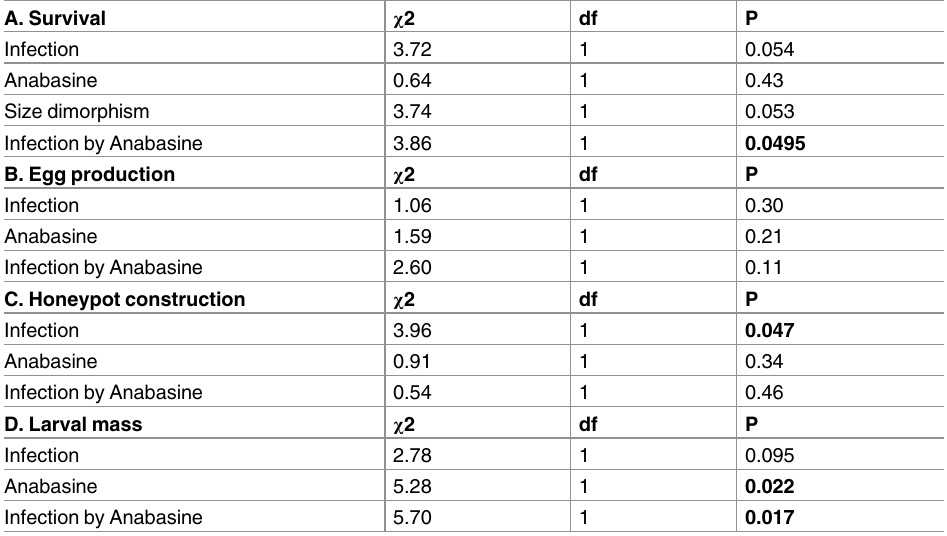
Table 3. Effects of Crithidia infection and anabasine on microcolony performance in the Life History Experiment. Microcolonies were observeddaily for (A) survival of individuals, (B) time to first egg production, and (C) time to first honeypotconstruction. Differencesin hazardrates across treatments were assessed by Cox mixed-effects proportional hazardsmodels. (D) Total larval mass per microcolony at 14 d after first egg production was tested for the subset of microcolonies that produced